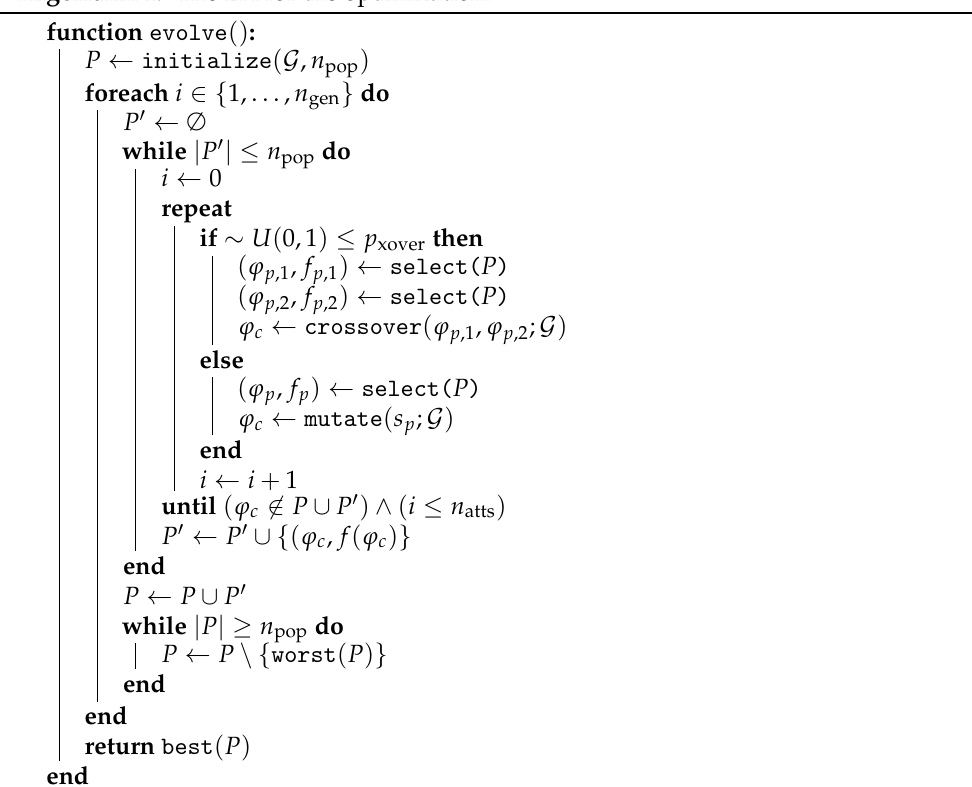
Algorithm 1: The EA for the